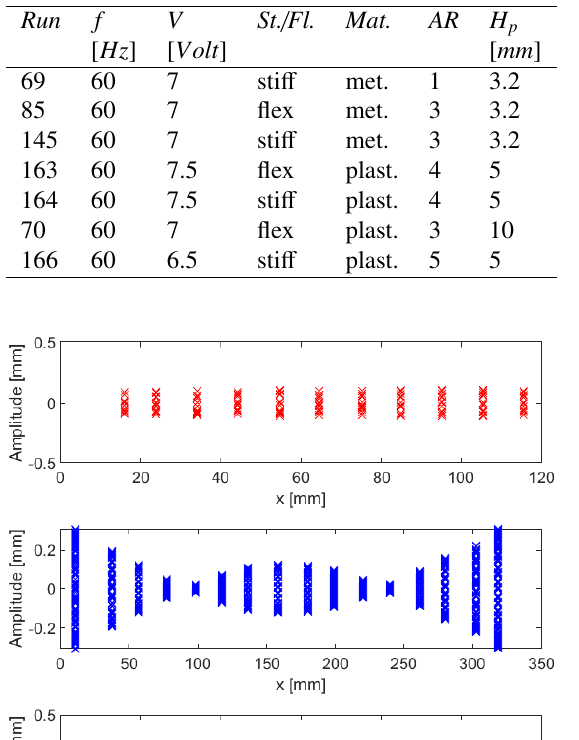
Table 1 : Experimental settings for each presented run.